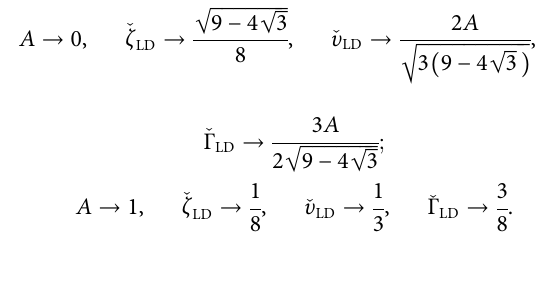
(cid:2) ζ (cid:1) − ζ / k as a function